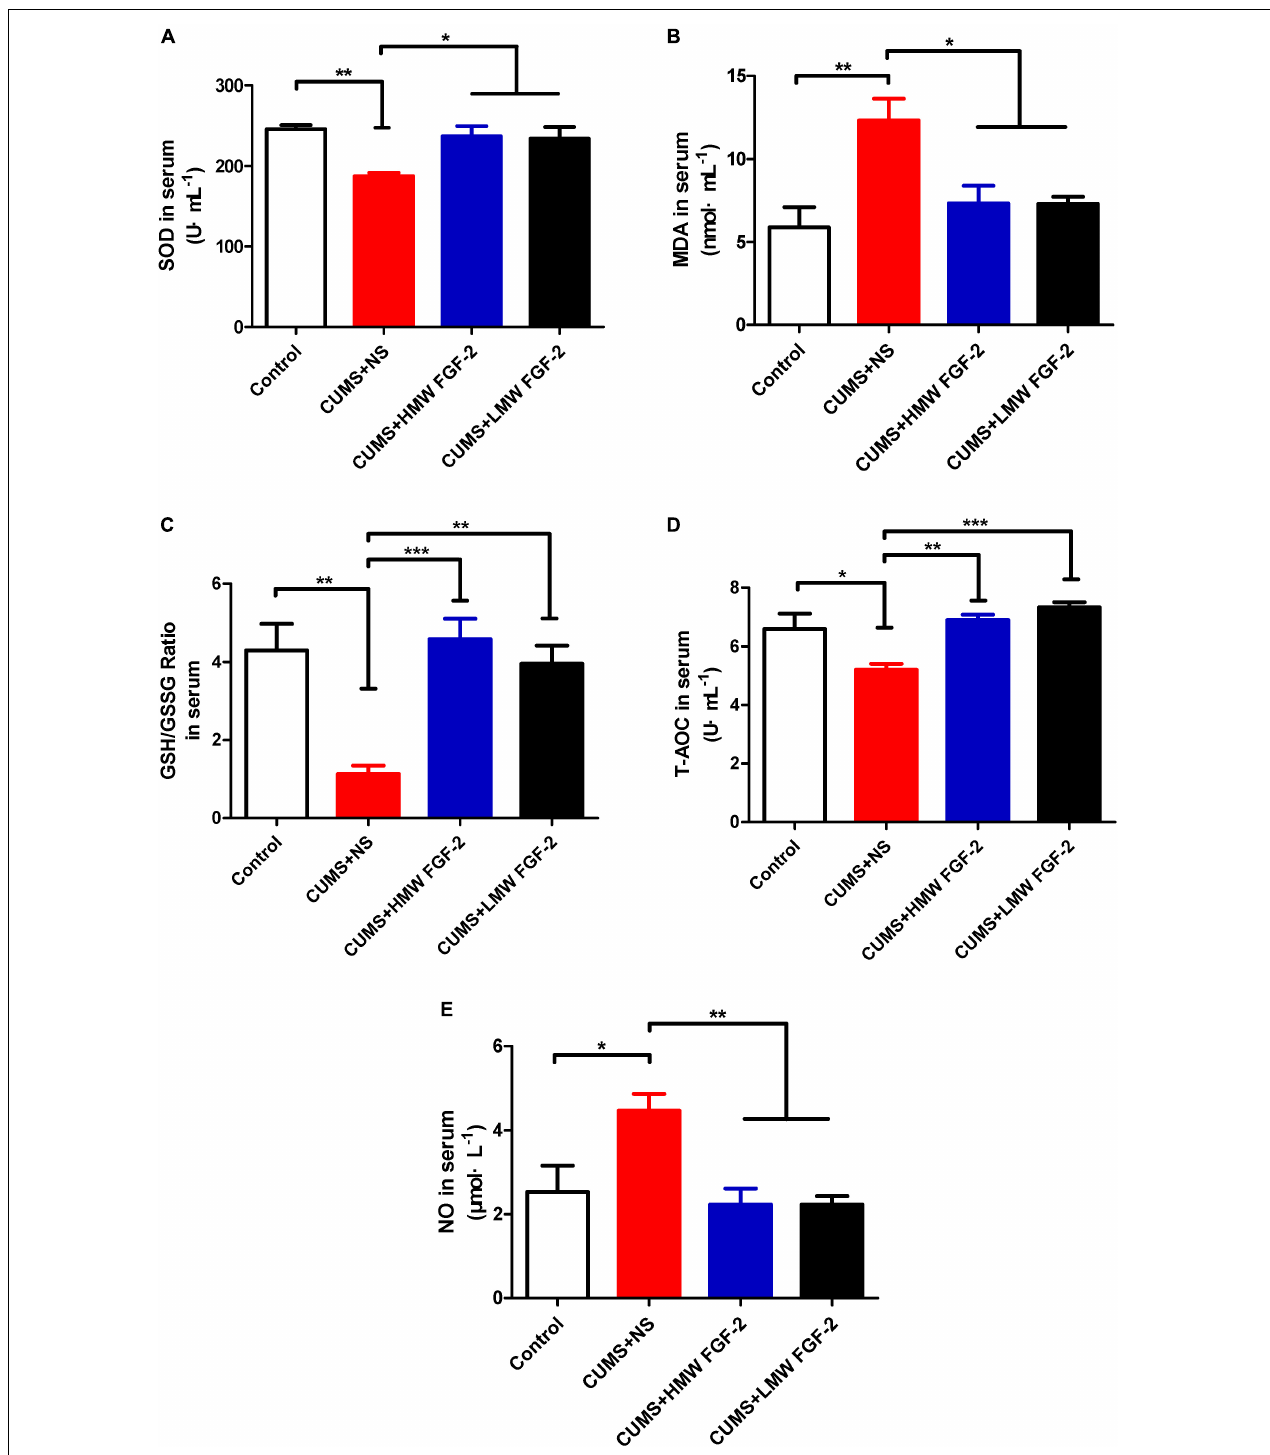
FIGURE 4 | Effects of FGF-2 on the changes in SOD and T-AOC activity and MDA, GSH, and NO levels in CUMS mice serum. (A) SOD activity. (B) MDA content. (C) GSH/GSSG ratio. (D) T-AOC activity. (E) NO content. Data are expressed as the mean ± SEM. SOD and T-AOC activity, as well as GSH levels were significantly decreased, while MDA and NO levels were significantly increased in the CUMS+NS group compared to those in the control group. However, after HMW FGF-2 or LMW FGF-2 administration, SOD and T-AOC activity, as well as GSH levels were significantly increased, while MDA and NO levels were significantly decreased. (A–E) , one-way ANOVA with Tukey’s post hoc test, n = 6, ∗ p < 0.05, ∗∗ p < 0.01, and ∗∗∗ p < 0.001.